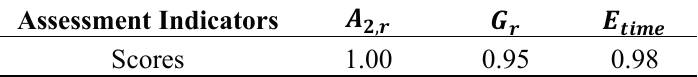
Figure 3. Measured inertial signals from the wrist of a healthy adult during the movement of shoulder flexion (three cycles). ( a ) Dominant hand; ( b ) non-dominant hand. Table 1. Calculated indicators for Case 1—A healthy adult.